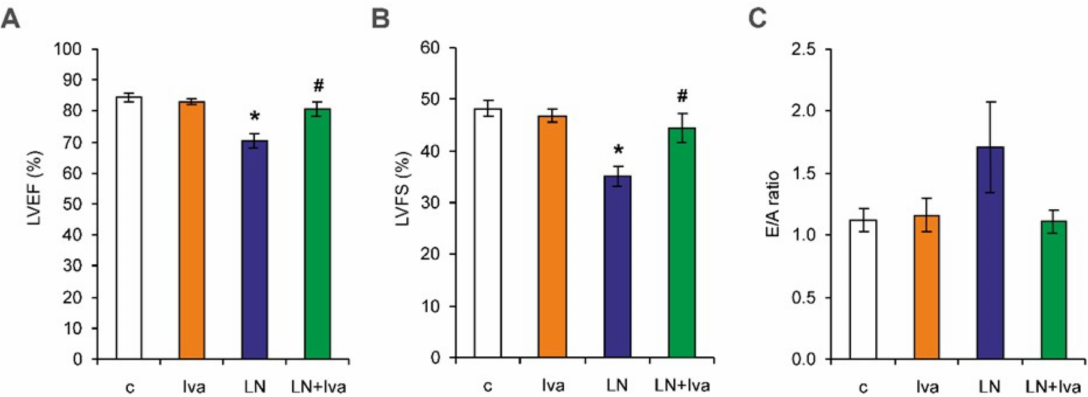
Figure 6. The influence of ivabradine (LN + Iva) on systolic function—left ventricular ejection fraction (LVEF) ( A ) and left ventricular fractional shortening (LVFS) ( B ), and diastolic function—the E/A ratio ( C ) of the left ventricle in L -NAME-treated rats. Wistar controls (c); L -NAME (LN); ivabradine (Iva); n = 6 per group; * p < 0.05 vs. c; # p < 0.05 vs. LN; results are expressed as mean ±